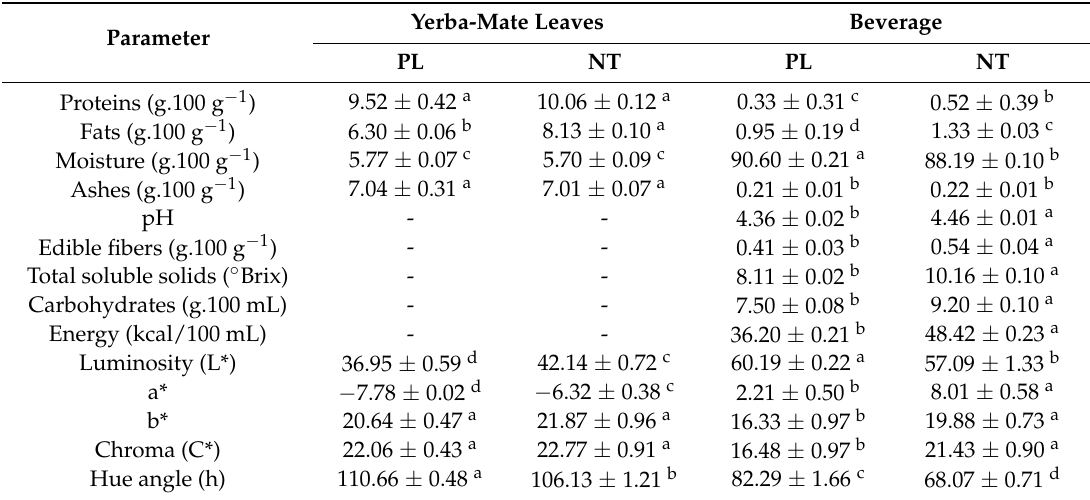
Table 1. Chemical composition and physicochemical parameters of yerba-mate leaves and